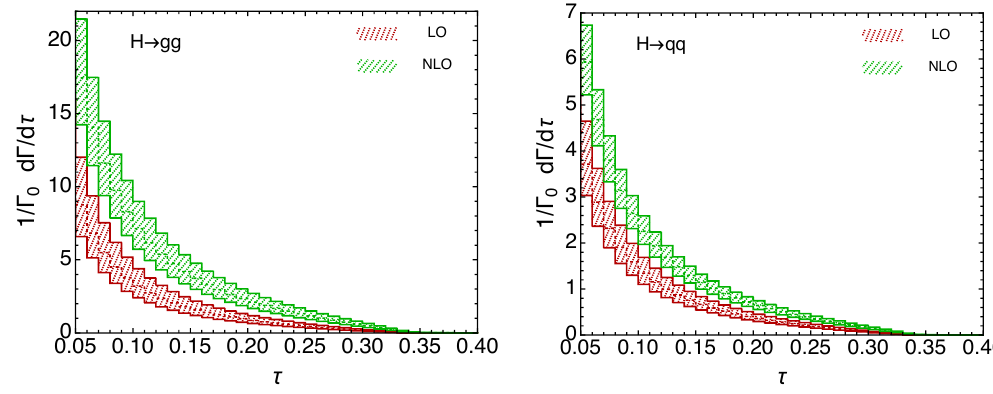
Figure 4 . Thrust distributions at LO and NLO in the Hgg (left plot) and Hq (cid:22) q (right plot) channels. are separately infrared (IR) divergent, while their sum is (cid:12)nite. In order to implement